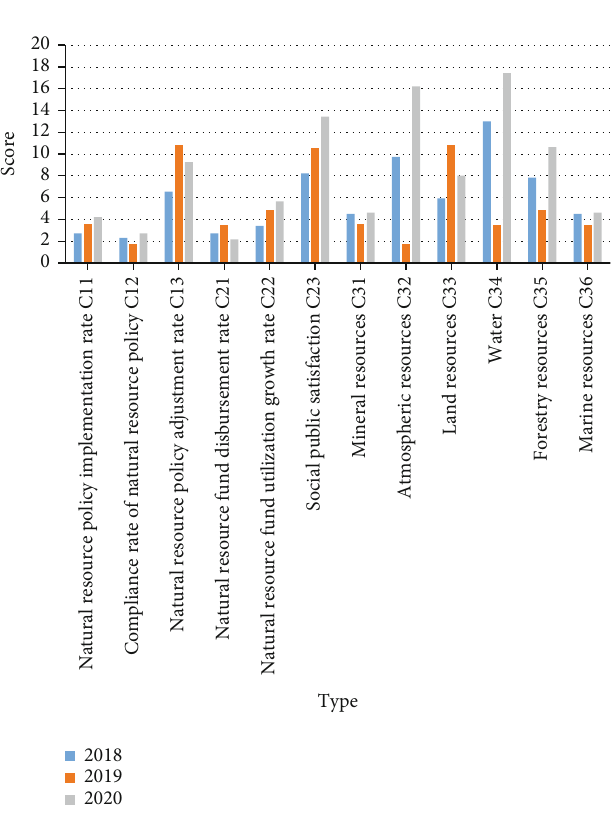
Figure 4: Comprehensive score of NR assets outgoing audit